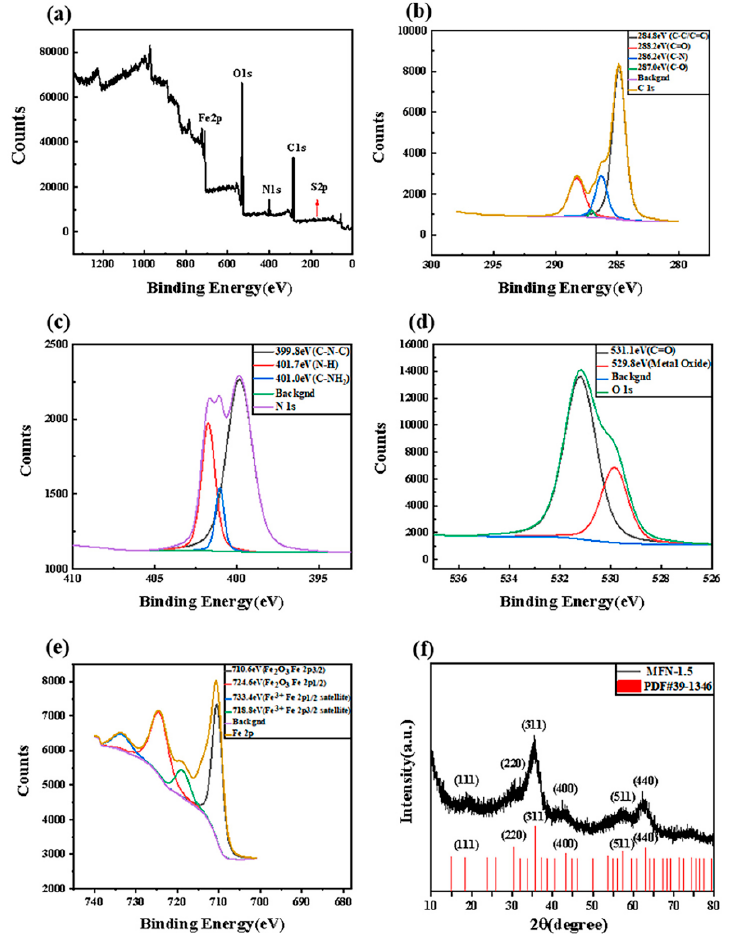
Figure 4. ( a ) The full-scale XPS spectrum of MFN-1.5; ( b ) C 1s spectrum; ( c ) N 1s spectrum; ( d ) O 1s spectrum; ( e ) Fe 2p spectrum; ( f ) XRD pattern of MFN-1.5. spectrum; ( e ) Fe 2p spectrum; ( f ) XRD pattern of